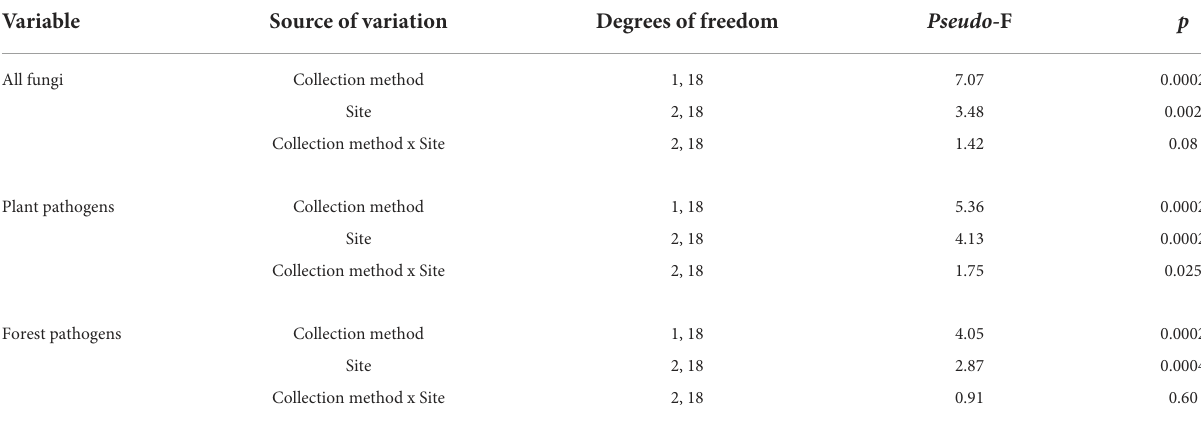
TABLE 3 Results of PERMANOVA (in PC-ORD) testing the effect of collection method (aerial spore collectors vs. Lindgren funnel traps) and site (New Brunswick, Nova Scotia, Ontario) on the community and relative abundance of fungal species detected. Variable Source of